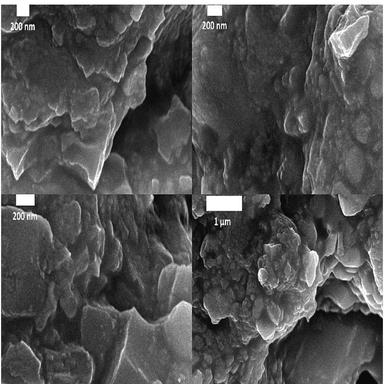
SEM images of as received powder sample.